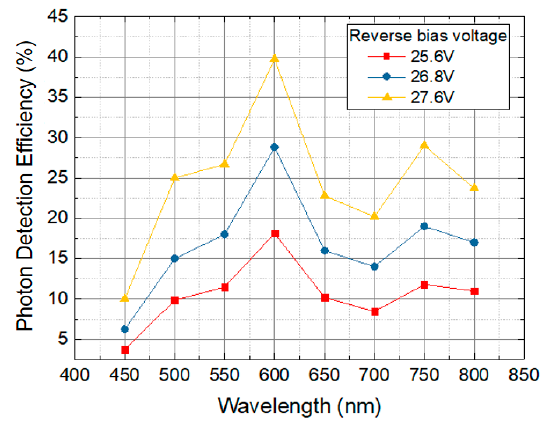
Figure 7. Dark count rate measured for varies bias voltages.